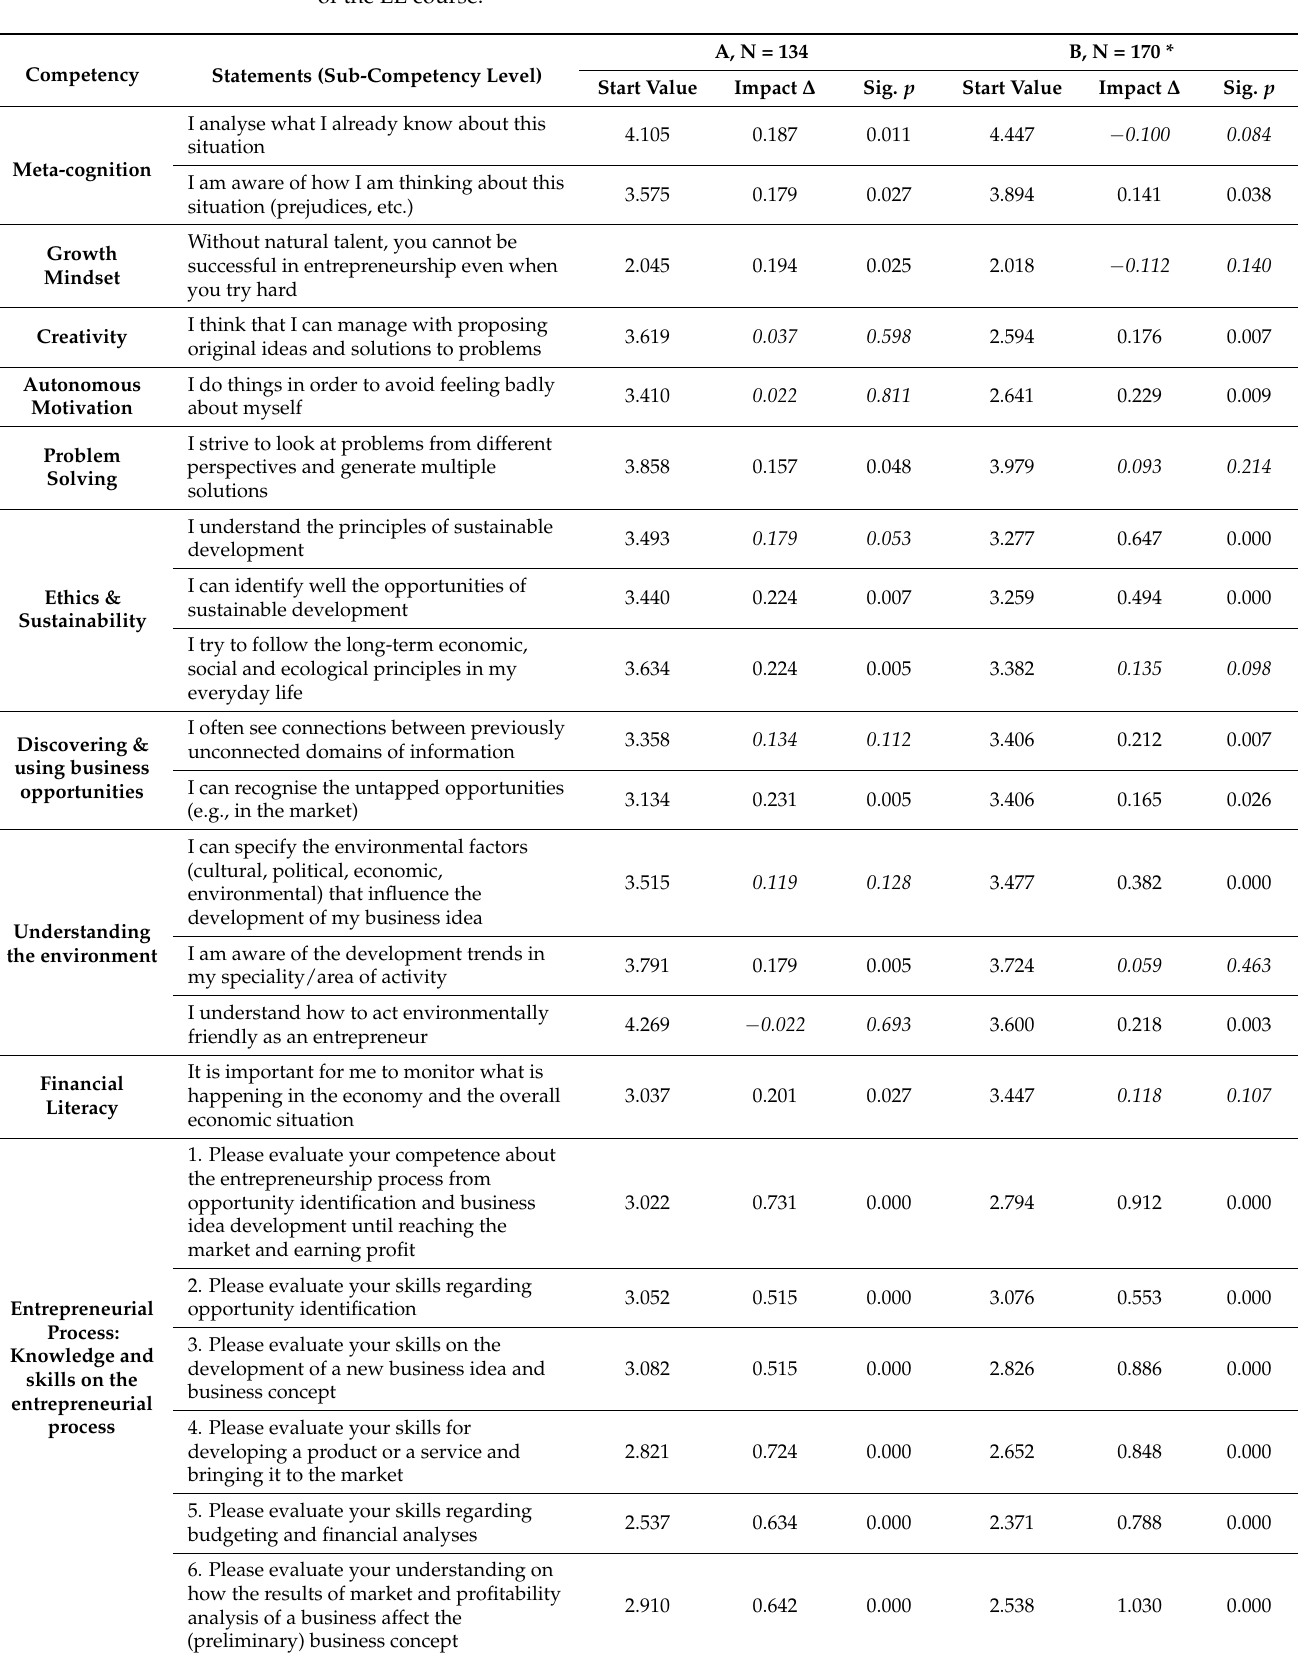
Table 1. Self-assessment by university A and B students at the start and impact/change ∆ at the end of the EE